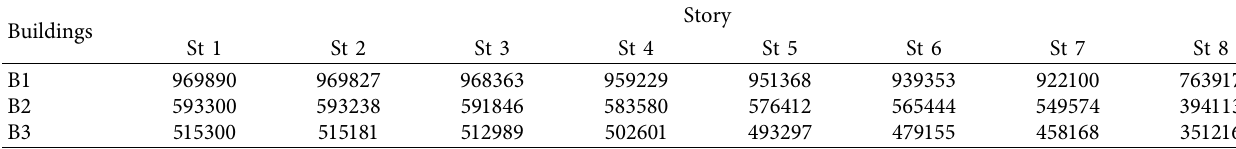
Table 2: Rotational weights (kN · m 2 ) of